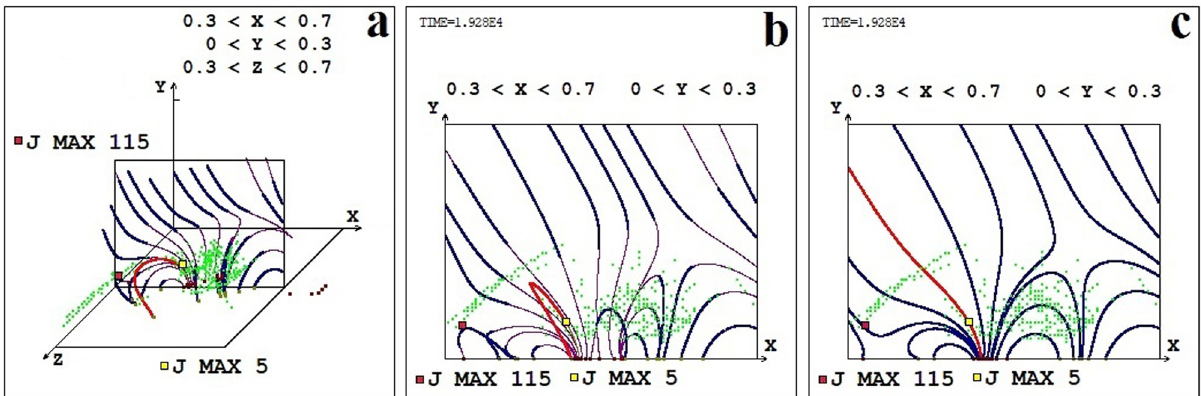
Figure 6: MHD simulation results and their comparison with observational data with the NoRH at 05/26/2003 05:34 ( time from the beginning of the calculation is 1.3628 days, × 1.928 10 4 in dimensionless units ) . Graphical representations are similar to those shown in Figure 4, but di ff erent time ( magnetic con fi gurations a – c at the time 05/26/2003 05:34 ) . The bold yellow dot shows the position of the 5th maximum, and the bold red dot shows the position of the 115th.